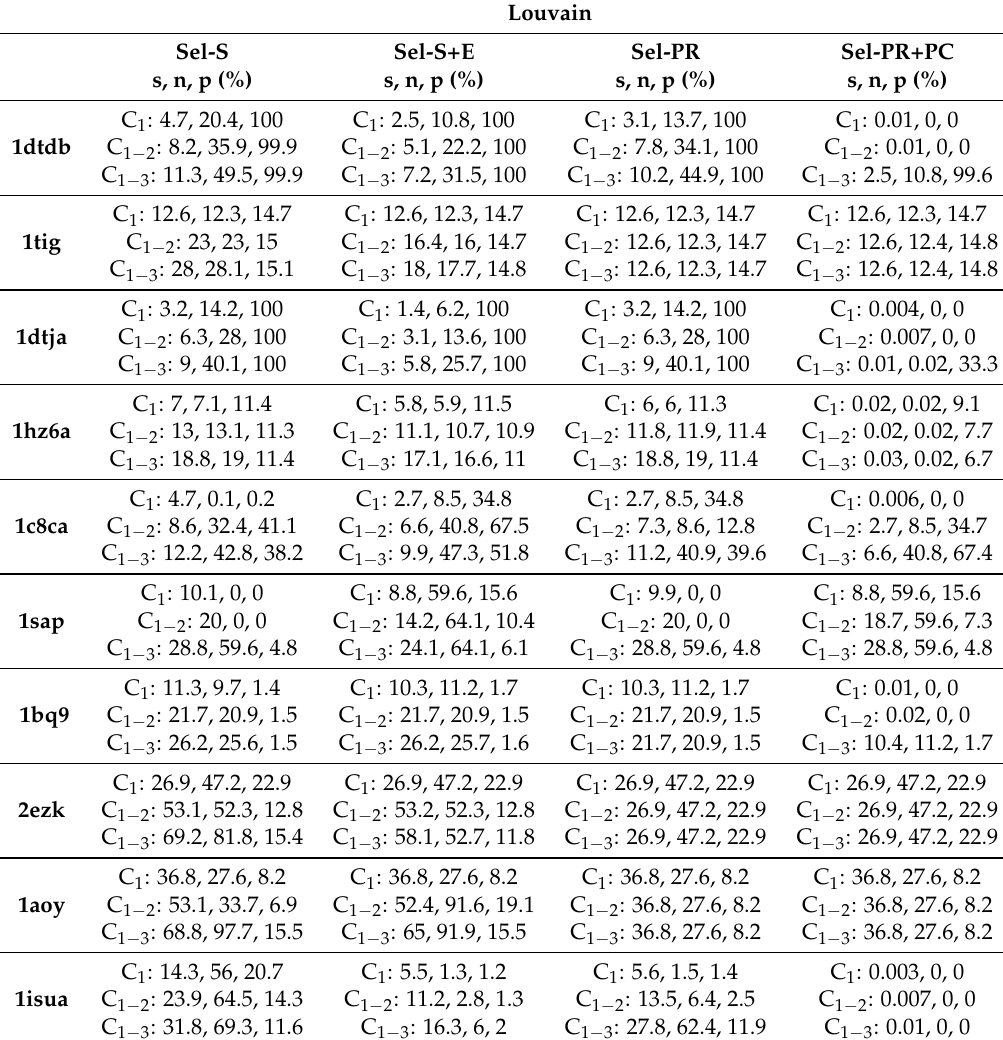
Table 3. The s , n , p of the communities selected by different selection strategies over communities identified by the Louvain algorithm on decoy datasets embedded as undirected